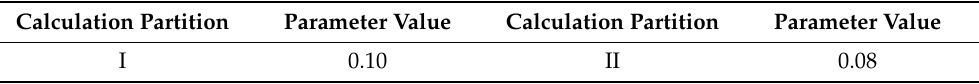
Figure 5. Partition of the coefficient of rain replenishment. Combined with the buried depth of the groundwater level and the lithology of the unsaturated zone, the precipitation infiltration coefficient in the simulation study area was finally determined as shown in Table 1. Table 1. Values of the coefficient of rain replenishment in the simulation